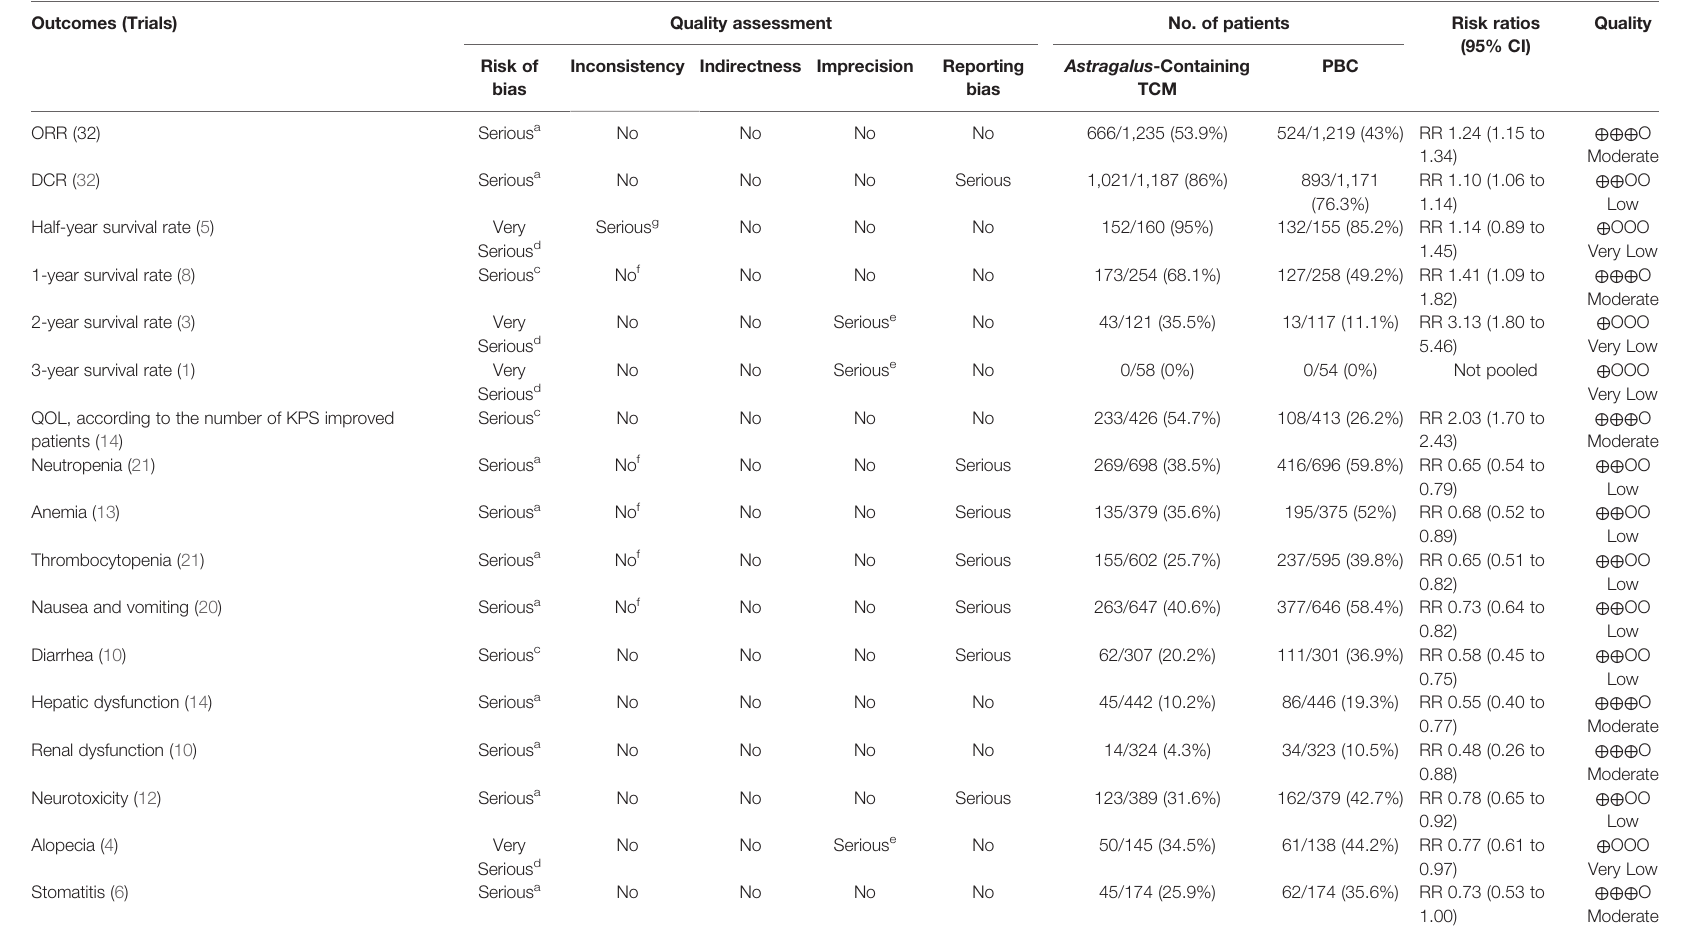
TABLE 6 | GRADE evidence pro fi le. TABLE 6a | GRADE evidence pro fi le of clinical ef fi cacy and